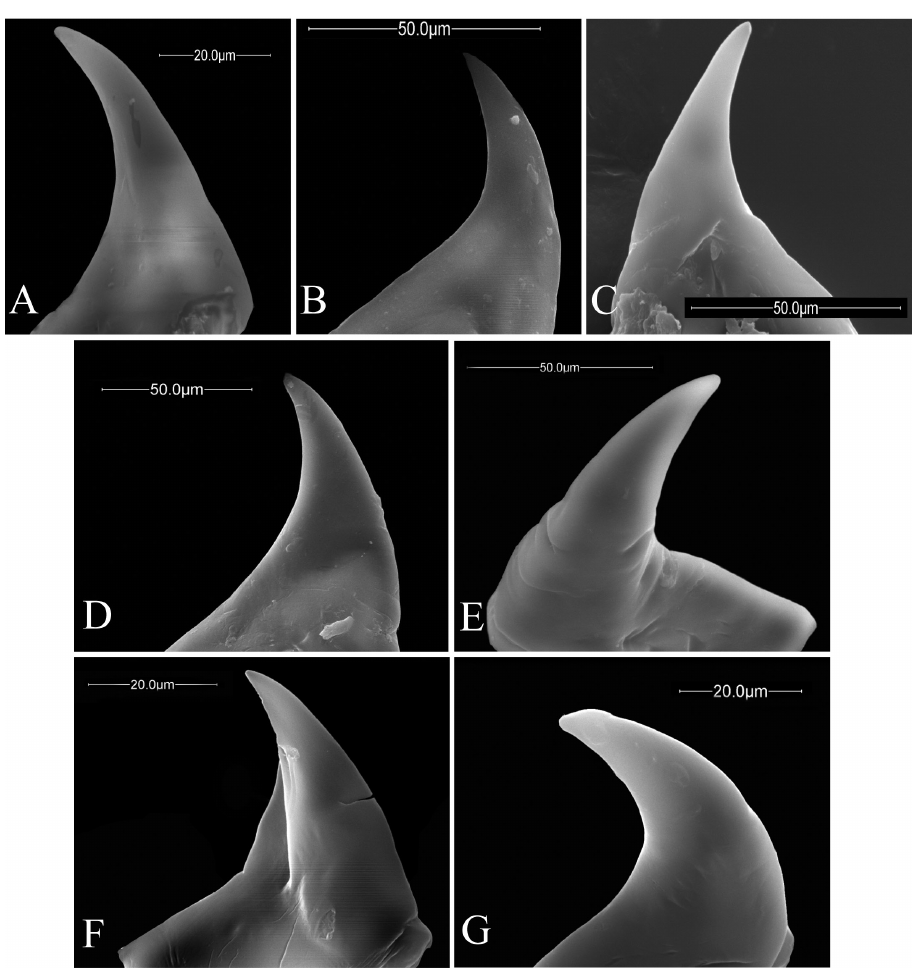
Figure 11. Anterior views of the right/left mandibles of Ormyrus terminal-instar larvae. A Ormyrus capsalis B O. diffinis C O. gratiosus D O. nitidulus E O. papaveris F O. pomaceus ex Trigonaspis mendesi (Cynipidae) G O. rufimanus